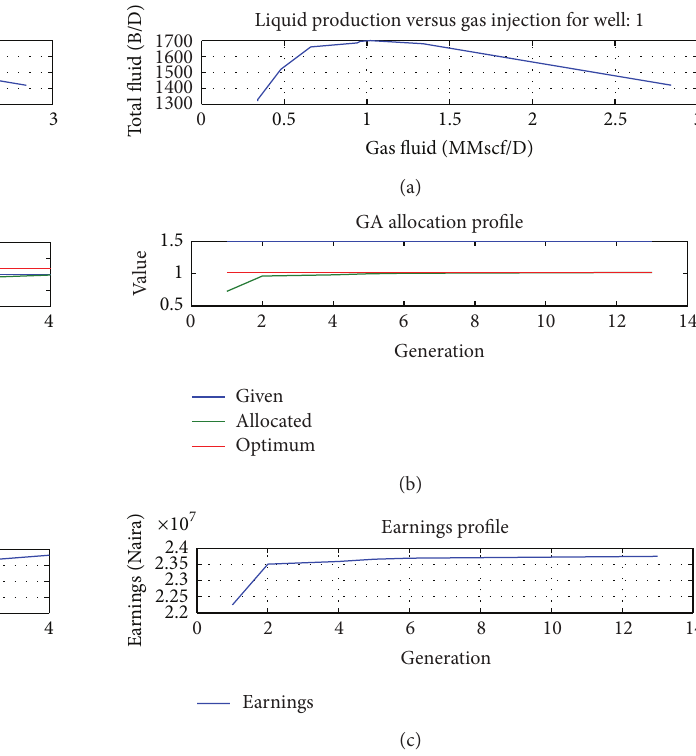
Figure 7: Well 1’s allocation profile, GA allocation profile, and earnings (Naira) profile in an unlimited